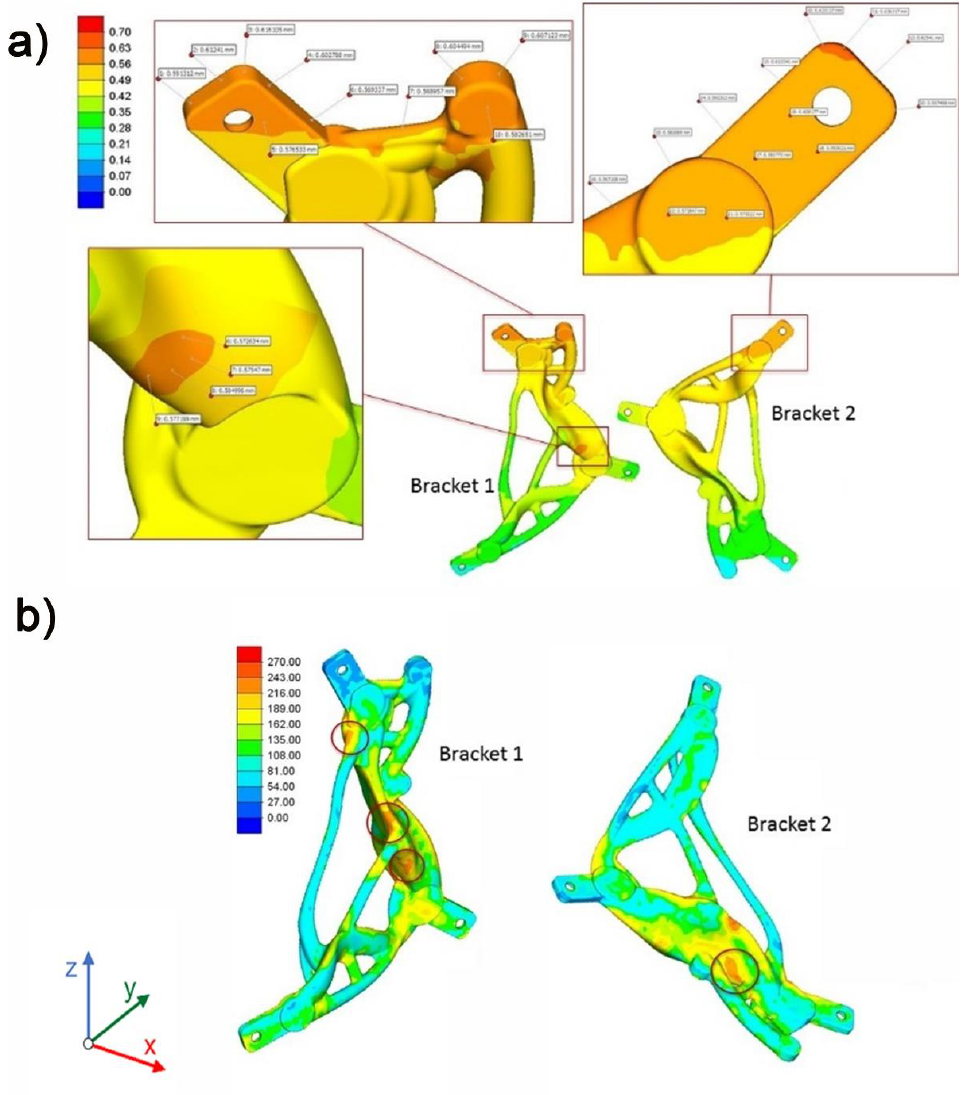
Figure 2. ( a ) Displacement (in mm) and ( b ) Von Mises stress (in MPa) distributions for the two relative orientations, Bracket 1 and Bracket 2, under exam. The orientation of the parts can be identified by the coordinate system at the bottom of the figure.